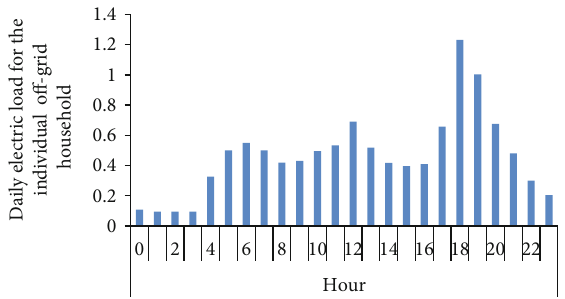
Figure 9: The daily load pro fi le for the stand-alone PV